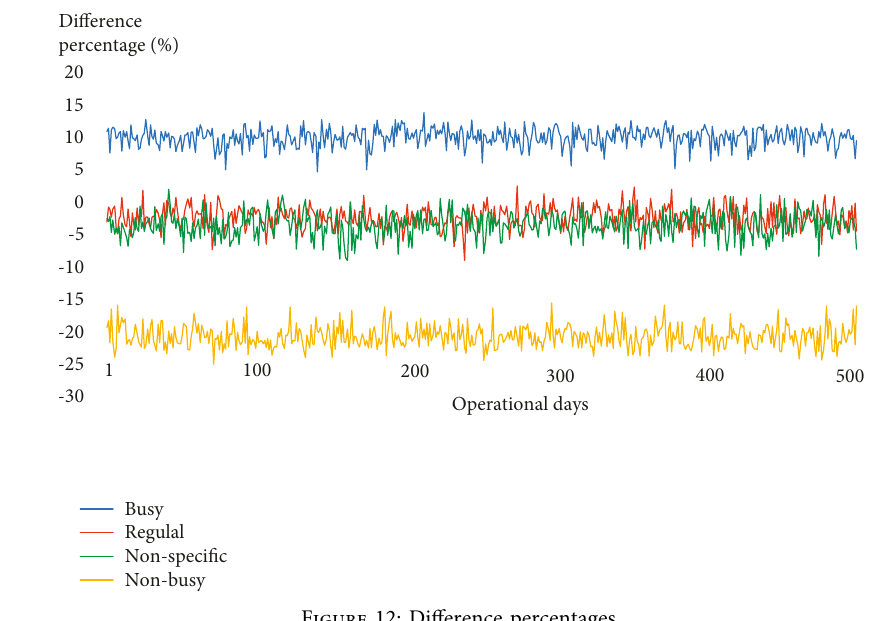
Figure 12: Difference